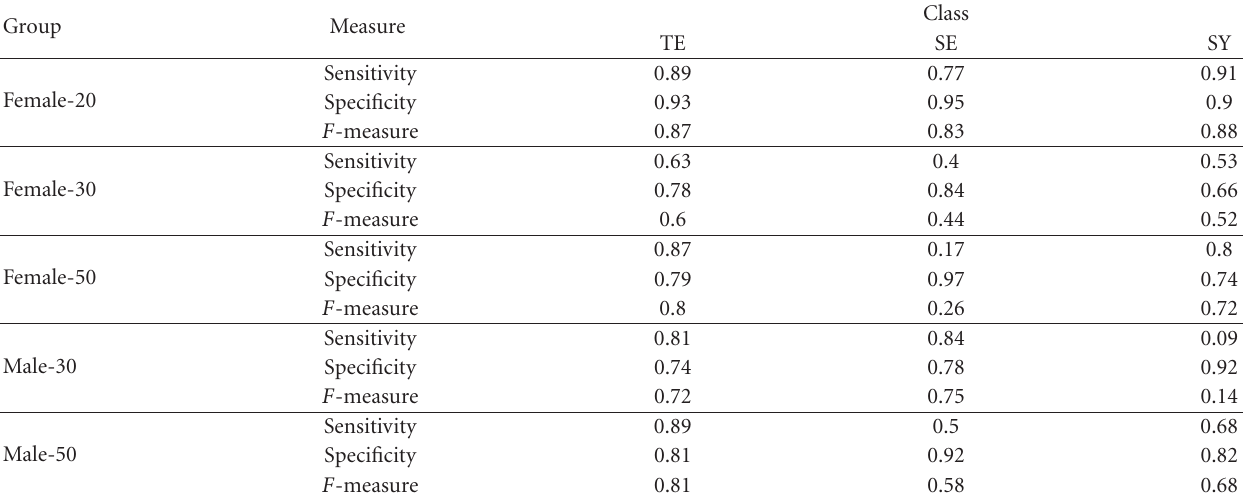
Table 3: Detailed performance evaluation of experiments using feature selection in all groups.